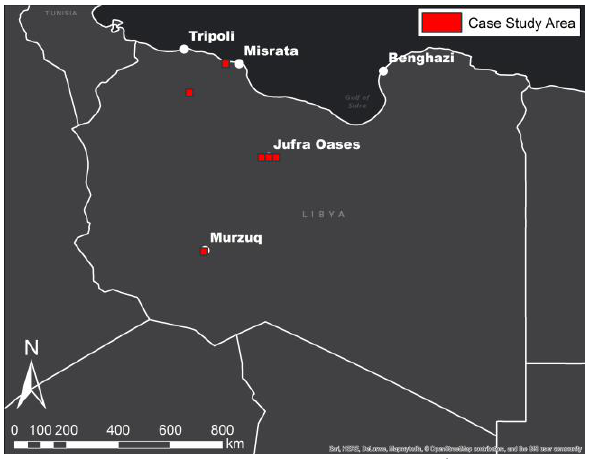
Figure 2. Location of case study areas in Libya (Basemap: Esri, HERE, DeLorme, MapmyIndia, © OpenStreetMap contributors, and the GIS user community).